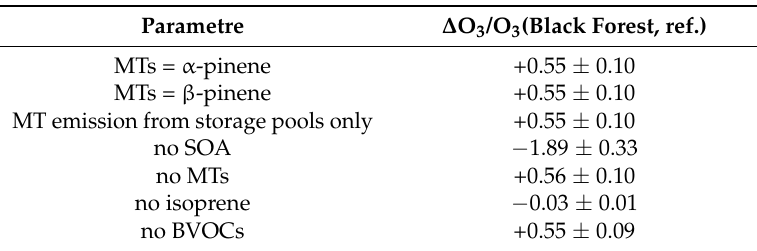
Table 5. Relative ozone increases at T = 35 ◦ C compared to reference